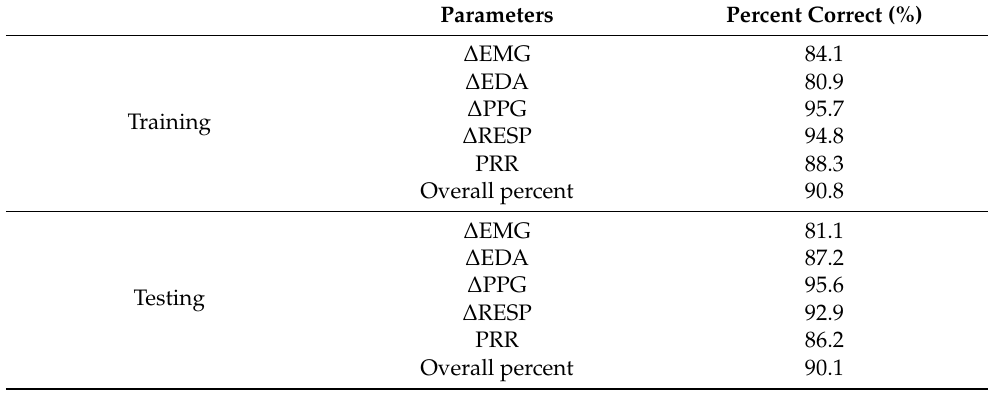
Table 5. Accuracy of parameters in the PRR model based on the validation set.